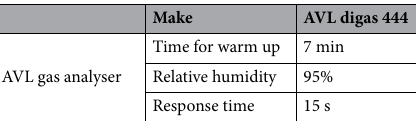
Table 4. Specifcation of gas analyser.